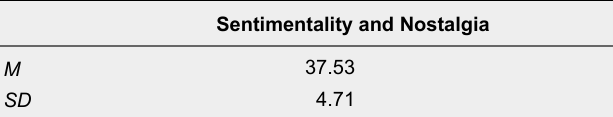
Norms in the Greek Sample on Total Scale SNEP Sentimentality and Nostalgia M 37.53 SD 4.71